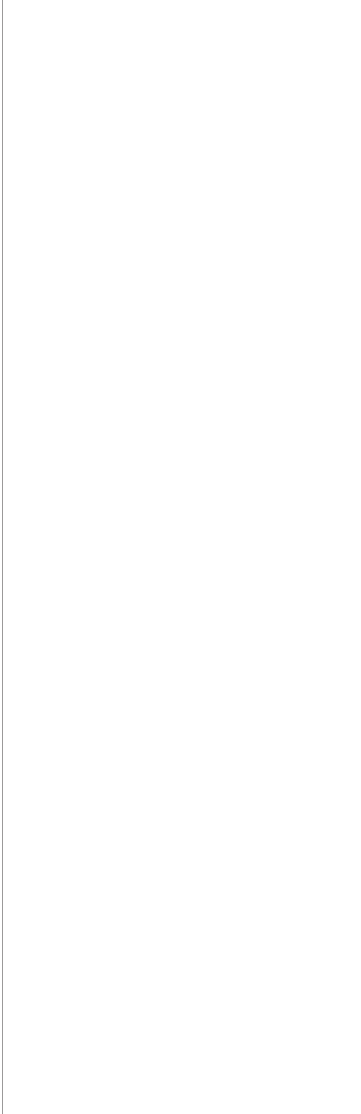
FIGURE 9 | In utero metformin exposure induced a change in spermatozoa morphology. (A) Micrograph of a normal and thin head abnormality. Quanti fi cation of the head spermatozoa morphology normalized against the total number of spermatozoa counted (control,n=7; metformin, n=12), Scale bar: 20 µm. (B, C) Immunocytochemistry of spermatozoa and testis section against DNA damage (green), the nucleus was stained with DAPI (blue). Right panel, quanti fi cation of spermatozoa stained for DNA damage, Scale bar: 20 µm (B) , 50 µm (C) Values are expressed as mean ± SEM. *p < 0.05, ***p <